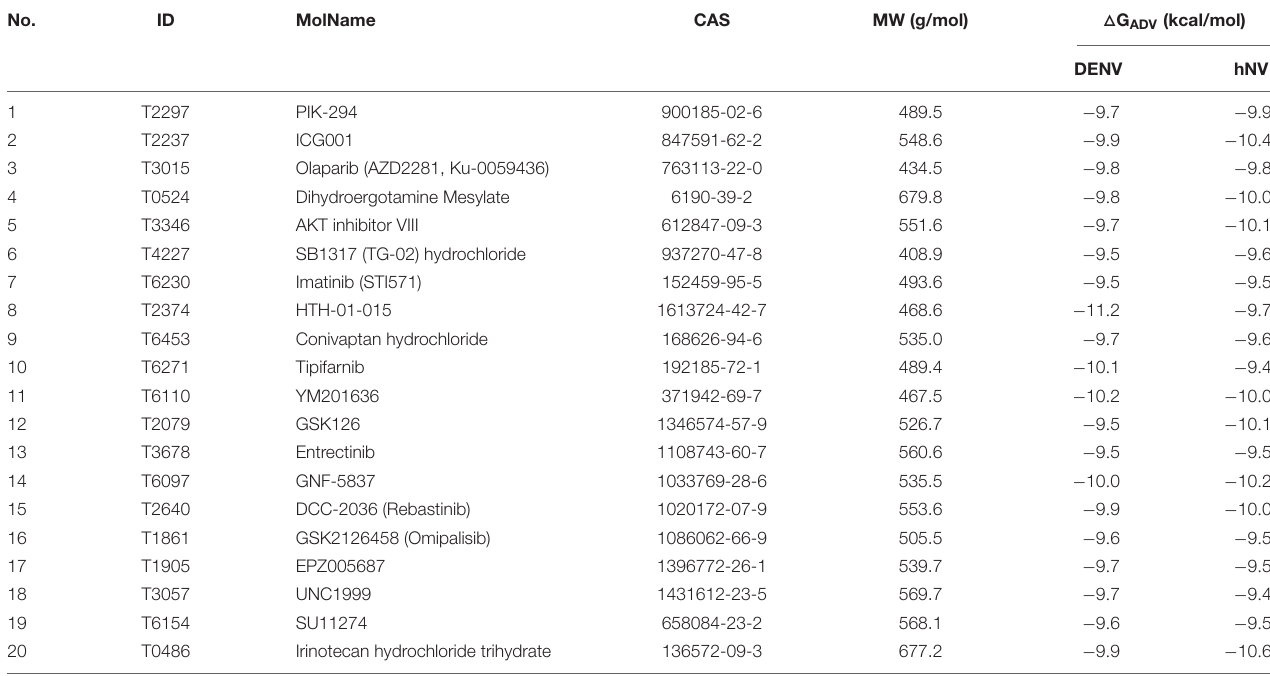
( Figure 4B and Supplementary Figure S3 ). To further examine the RAI-13 inhibition of norovirus RNA replication, we infected RAW264.7 cells with MNV(SH1603) in the presence of different concentrations of RAI-5, RAI-13, and RAI-14. Among them, RAI-13 exhibited a dose-dependent inhibition of MNV infection, with an EC50 of 2.01 µ M ( Figure 4C ). In addition to the reduction of total RNA level of MNV, decrease of the